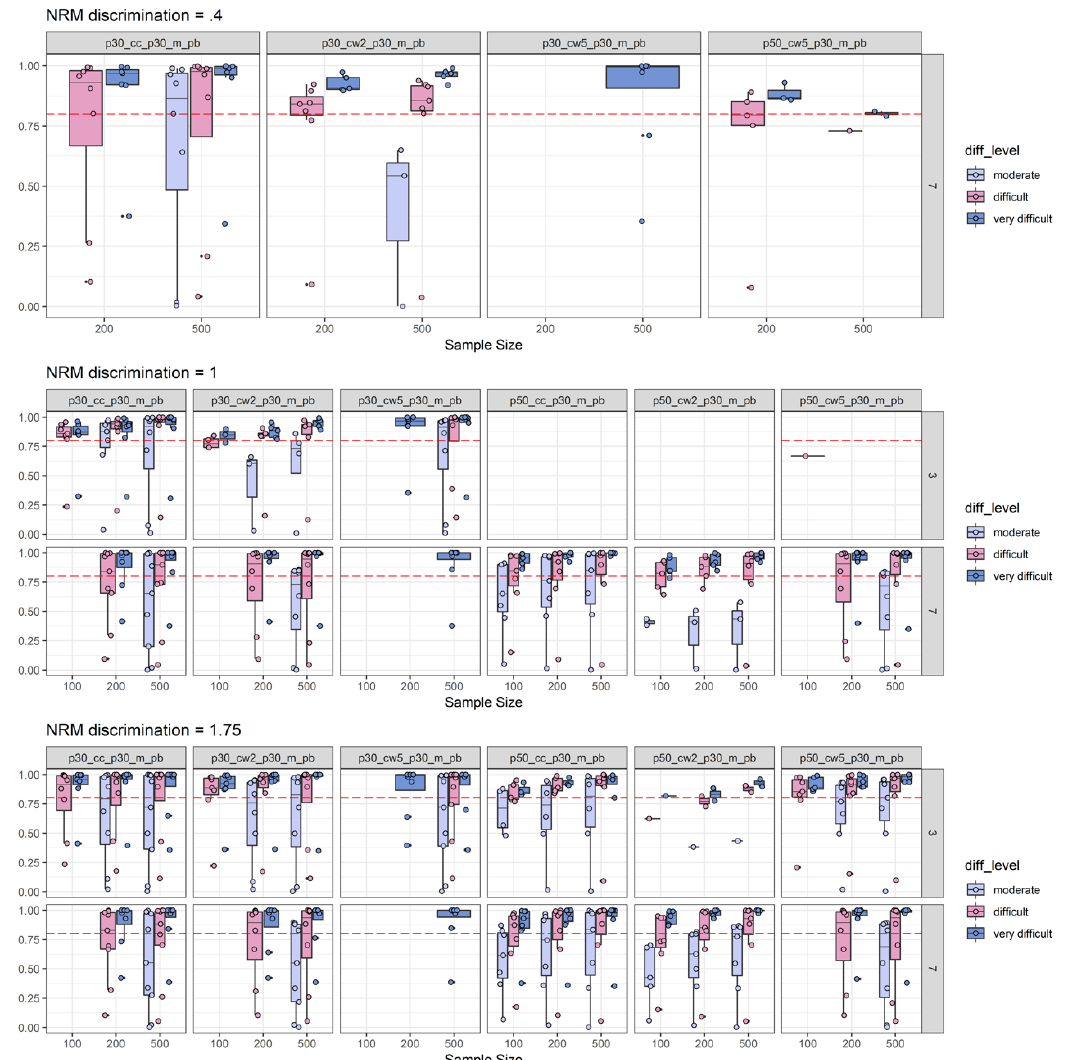
Figure A8. Number-of-items split of empirical power analysis: Depiction of the empirical power (y-axis) under the boundary condition that the average PB DC is smaller than −0.30. Power is depicted as a function of NRM discrimination, sample size (x-axis), number of distractors, and discrimination effect sizes combined with effect size thresholds. The horizontal red dashed line represents the target power level of 0.80. For more explanations, see Figures 2 and 3.